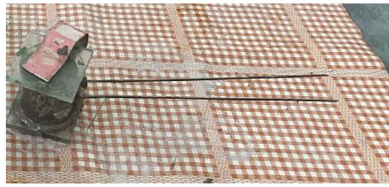
Figure 6. The view of normalized cement paste with MSWI slag in Vicat’s apparatus (authors’ photo).